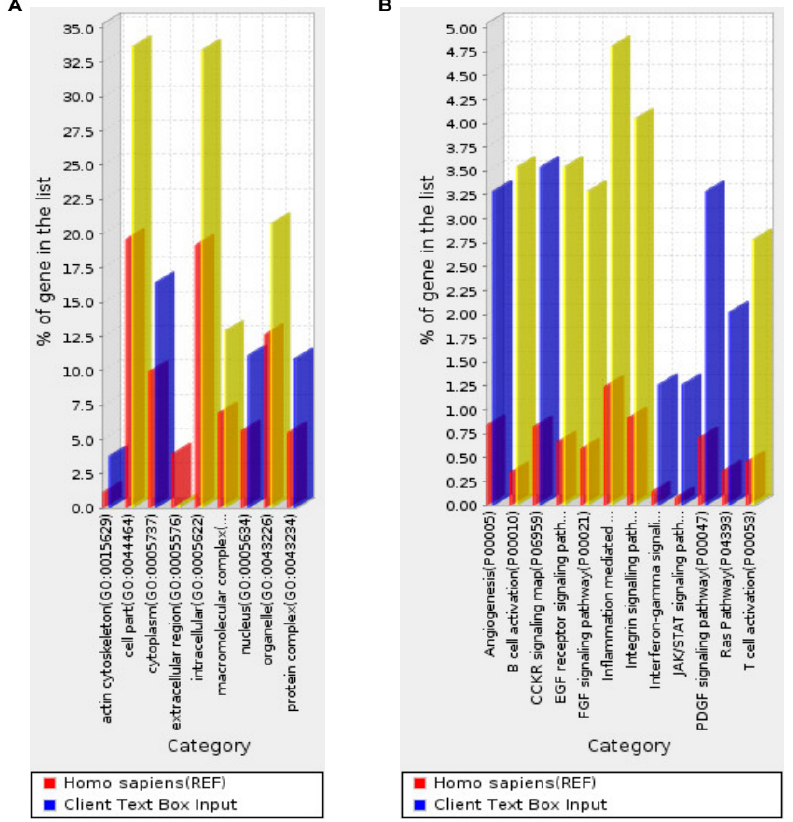
Figure 2. Over-represented annotation terms in the list of 395 genes that are most stably detected in maternal blood. ( A ) Over-represented protein analysis through evolutionary relationships (PANTHER) gene ontology (GO)-Slim terms in cellular components. ( B ) Over-represented PANTHER pathways. The list of genes represented by exons detected across all samples at a CV in the lowest 10th percentile (orange circles in Figure 1) is subjected to the over-representation test. The percentage of genes in each category of cellular component GO-terms or pathways among this list of most stably detected genes in maternal blood (client input, blue or yellow bars) is shown. It is compared with the percentage of genes in the corresponding category among the entire list of genes in the human reference genome (REF, red bars). p -Values are adjusted for multiple testing by the Bonferroni method. Blue bars, p < 0.05. Yellow bars, p < 0.001. Red bar, baseline for comparison.